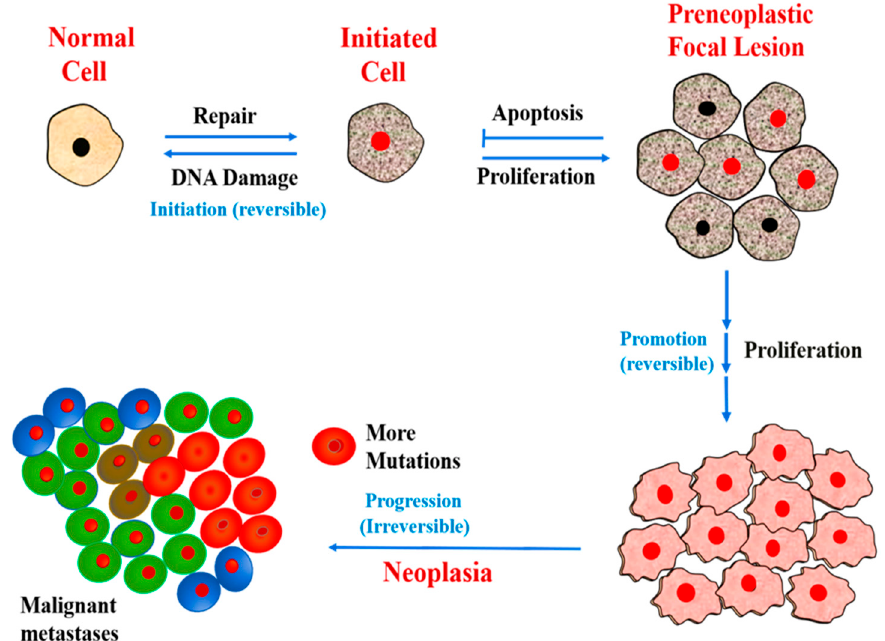
Figure 2. Stages in the development of cancer.